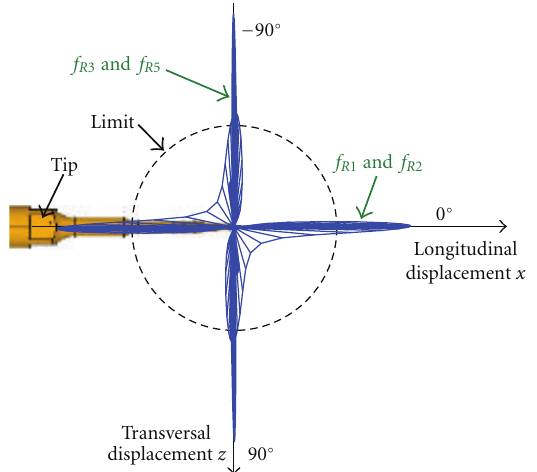
Figure 13: Plotted oscillation of one new scaler.